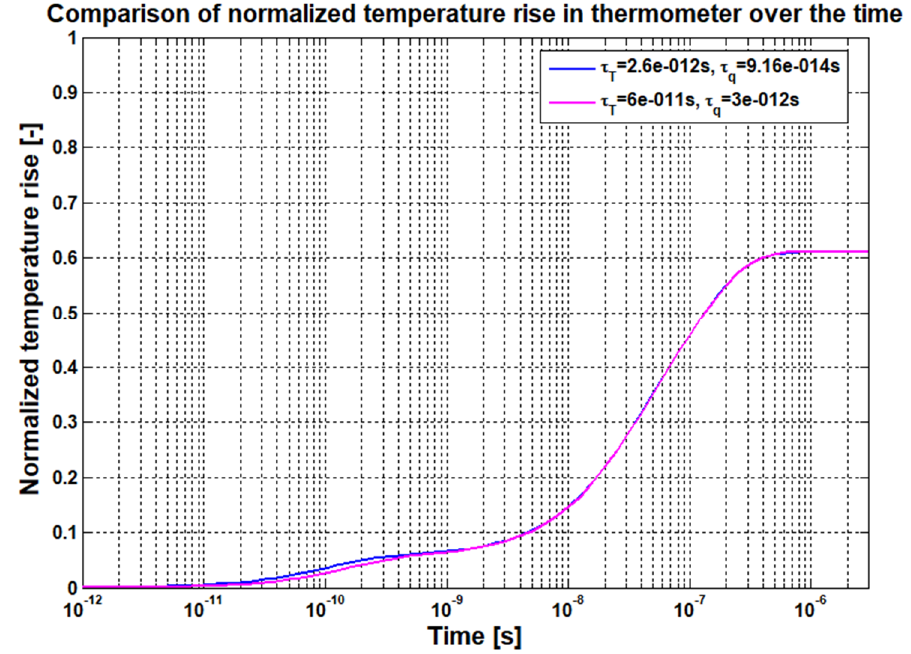
Figure 4. Average temperature rises over the time inside temperature sensor (excluding investigation in Section 2.4).